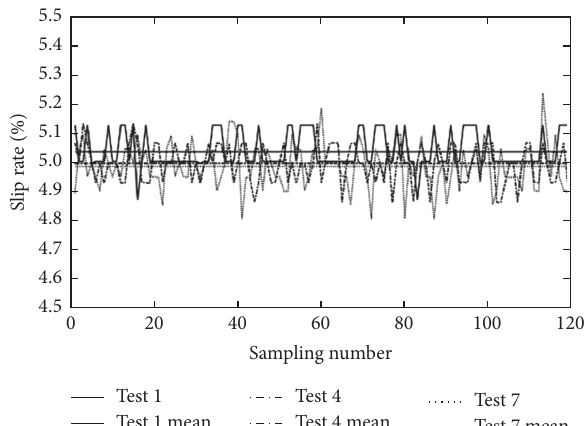
Figure 13: Tests 1, 4, and 7 slip rate statistics and mean curve.